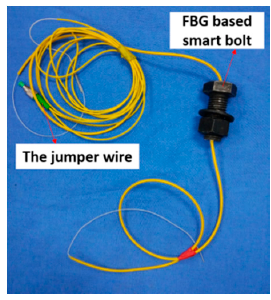
Figure 9. A photo of the FBG-based smart bolt that is used to measure the axial loading.